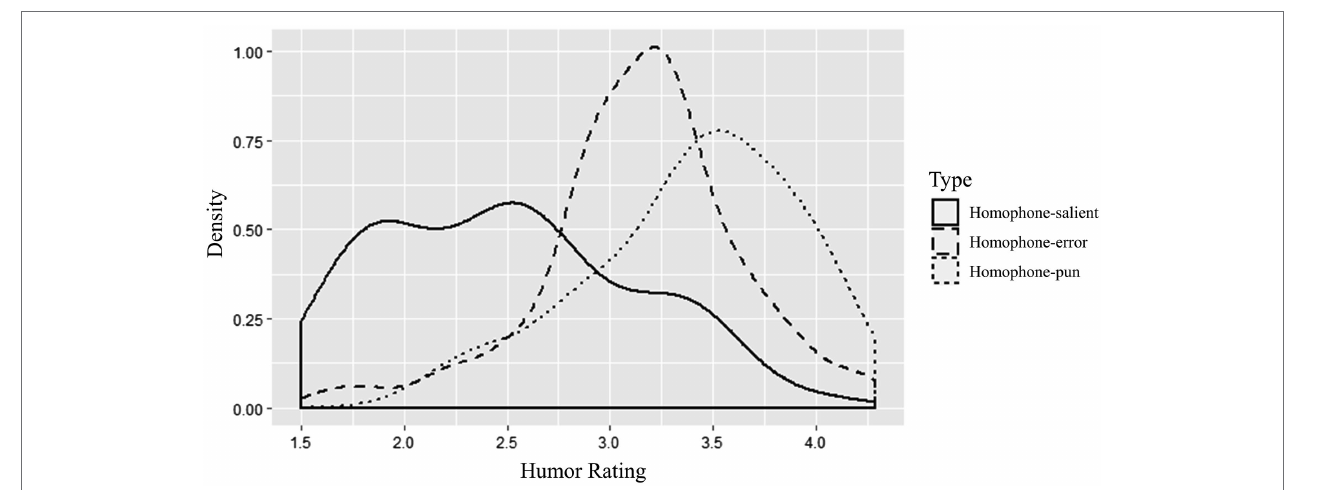
FIGURE 2 | Density plot of humor ratings for each sentence